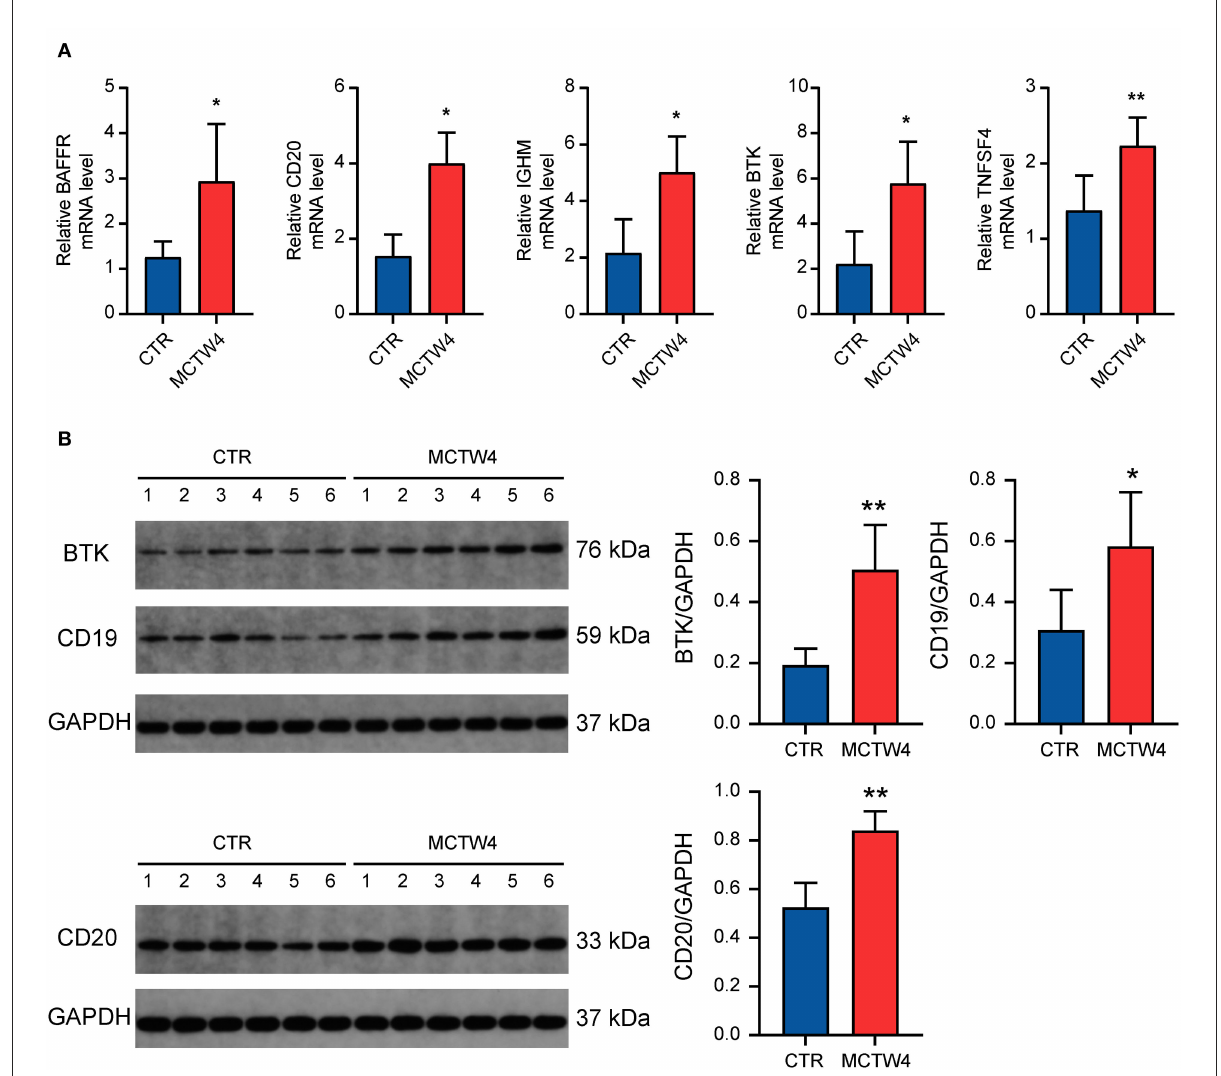
FIGURE6 Validation of the expression of critical humoral immune response-associated genes. (A) Real-time PCR analysis. Data were shown as mean ± SD. n = 3 MCT-treated rats at 4 weeks, and n = 5 control. * P < 0.05 vs control; ** P < 0.01 vs. control. (B) Western blot analysis. Data are shown as mean ± SD. n = 6 MCT-treated rats at week 4, and n = 6 control. * P < 0.05 vs. control; ** P < 0.01 vs. control. CTR, control; MCTW4, MCT treatment for 4